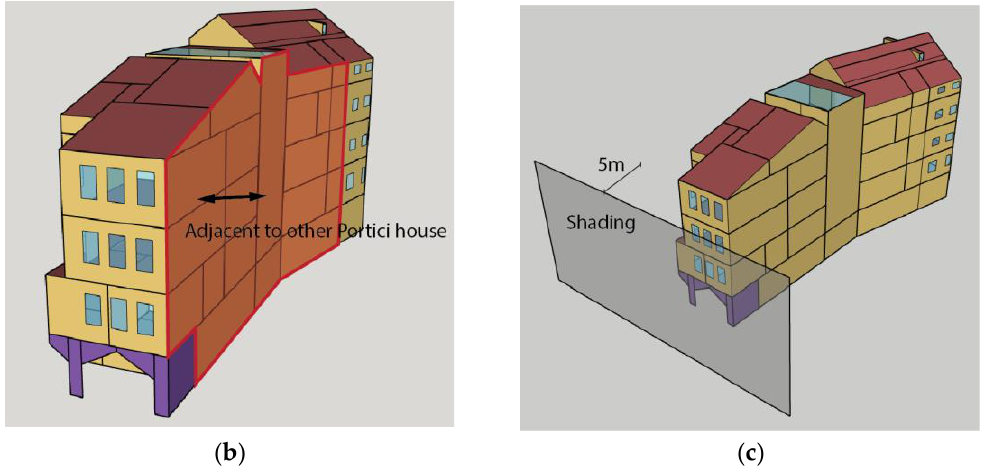
Figure 13. Portici house of Climate zone I ( a ) and boundary conditions in adjacent buildings ( b ) and shading from the opposite buildings ( c ) as modelled in this study.